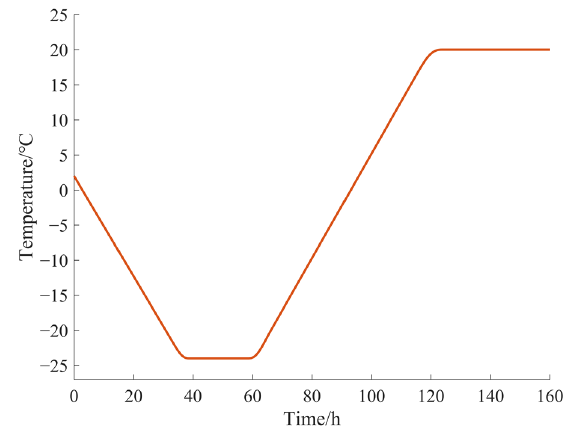
Figure 3. Temperature condition of the upper boundary (°C).